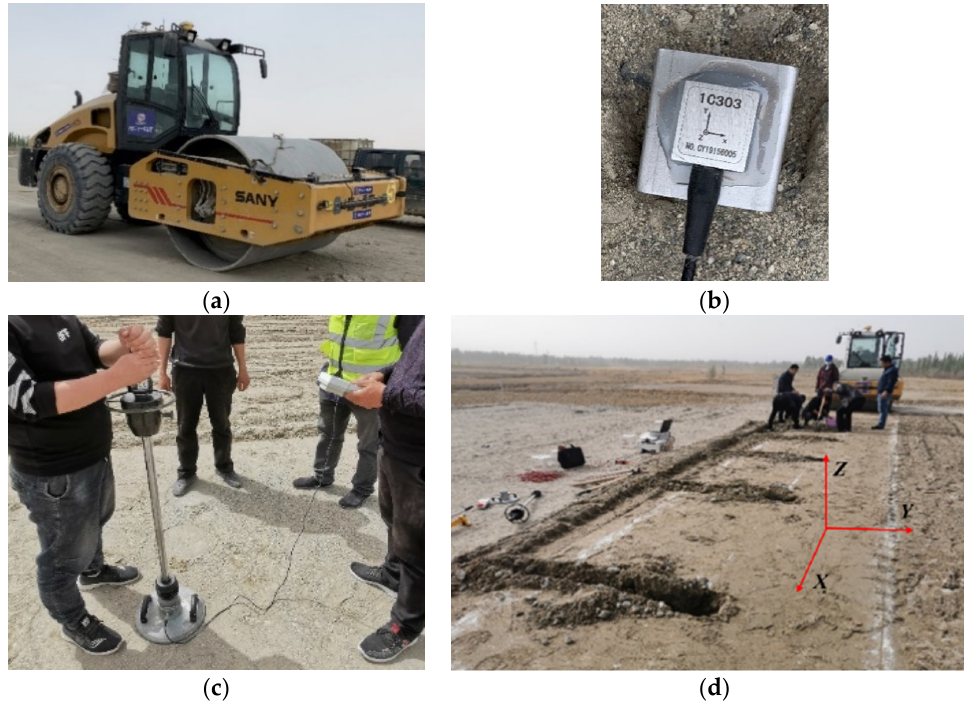
Figure 2. Test site and test equipment. ( a ) Vibratory roller. ( b ) Accelerator sensor. ( c ) Plate load test. ( d ) Test site.